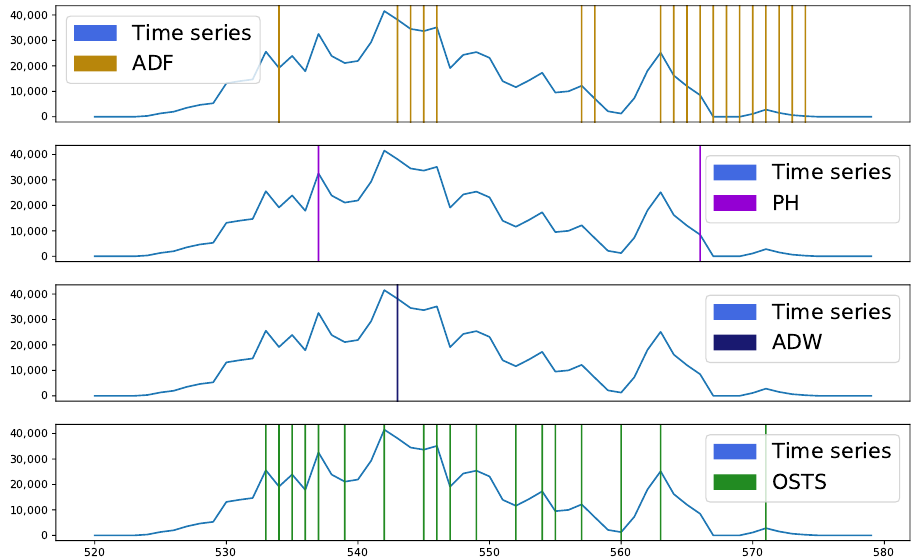
Figure 5. Segmented samples of dataset C (chunk from 520 to 580 samples). ADF removed 19 samples, PH removed 2 samples, ADW removed a single sample and OSTS removed 18. Unlike the case of dataset A, the ADF segmenter performed many segmentations like the OSTS, but in different regions, while the other segmenters considered the region as